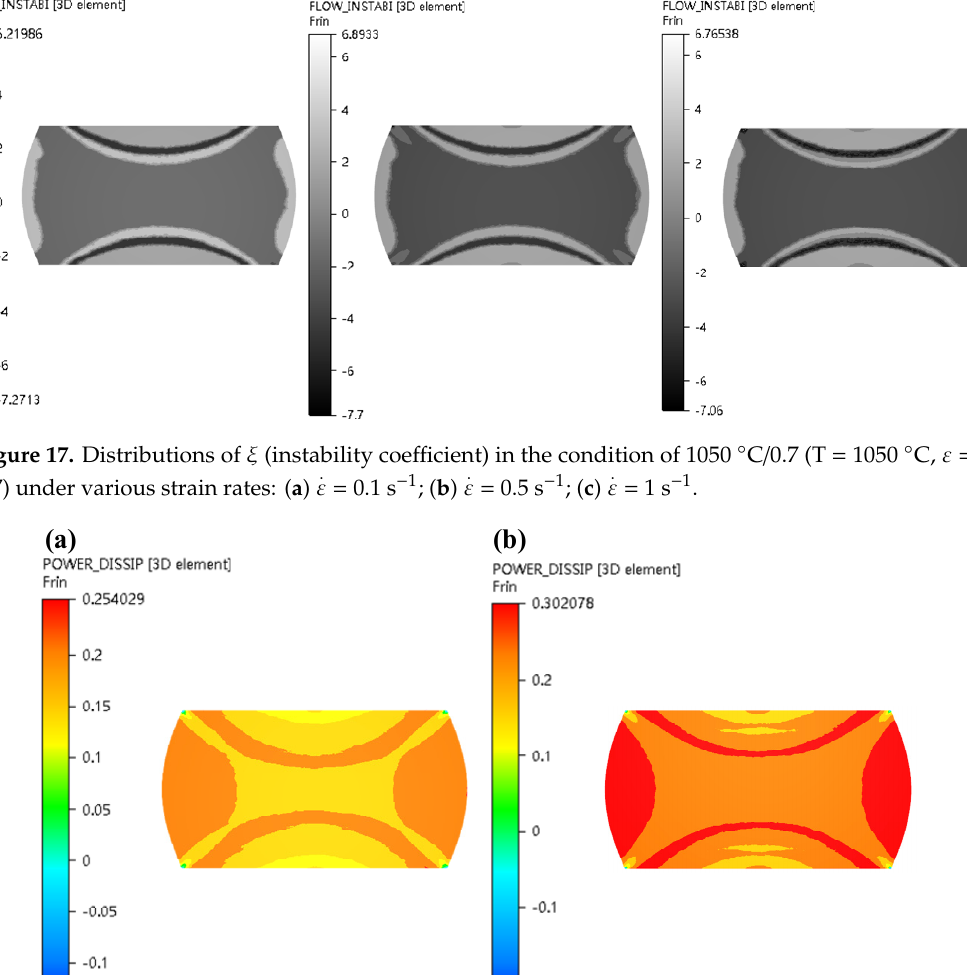
Figure 18. Distributions of η (power dissipation coe ffi cient) in the condition of 0.5 s − 1 / 0.7 ( 0.5 s − 1 , ε = 0.7) under various temperatures: ( a ) T = 1000 °C; ( b ) T = 1100 °C.